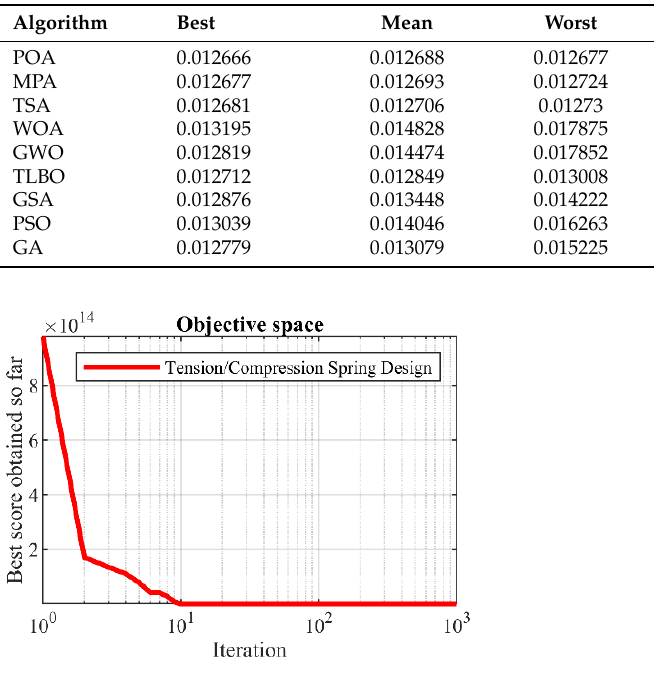
Figure 12. POA’s performance convergence curve on tension/compression